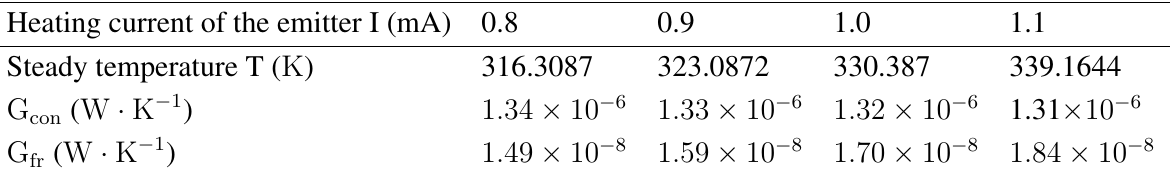
Table 2. Fitting result of thermal time delay experiment.